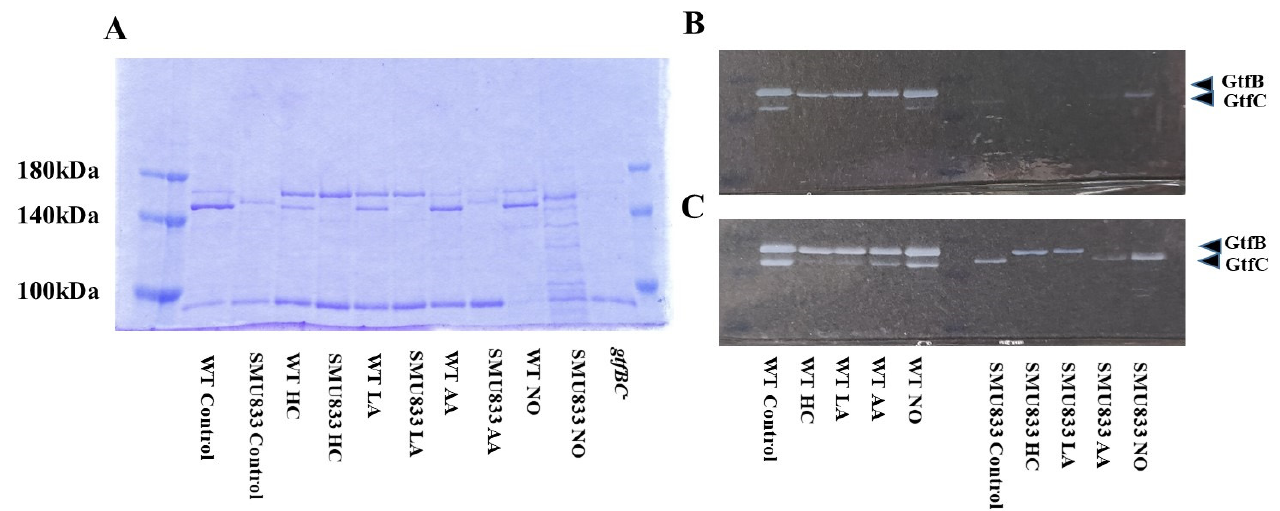
Figure 6. Effects of initial pH condition on Gtfs amounts and activities in the MVs from S. mutans SMU833 -. . Amounts of Gtfs (GtfB and GtfC) on MVs from S. mutans UA159 (WT) and S. mutans UA159. SMU833 - extracted in control, HC, LA, AA, and NO, and S. mutans UA159 gtfBC - were analyzed in 6% polyacrylamide gel, SDS-PAGE and CBB staining ( A ), and zymography for overnight ( B ) and three days culture ( C ) using buffer involving sucrose. Representative data from more than three independent experiments are shown in the pictures.